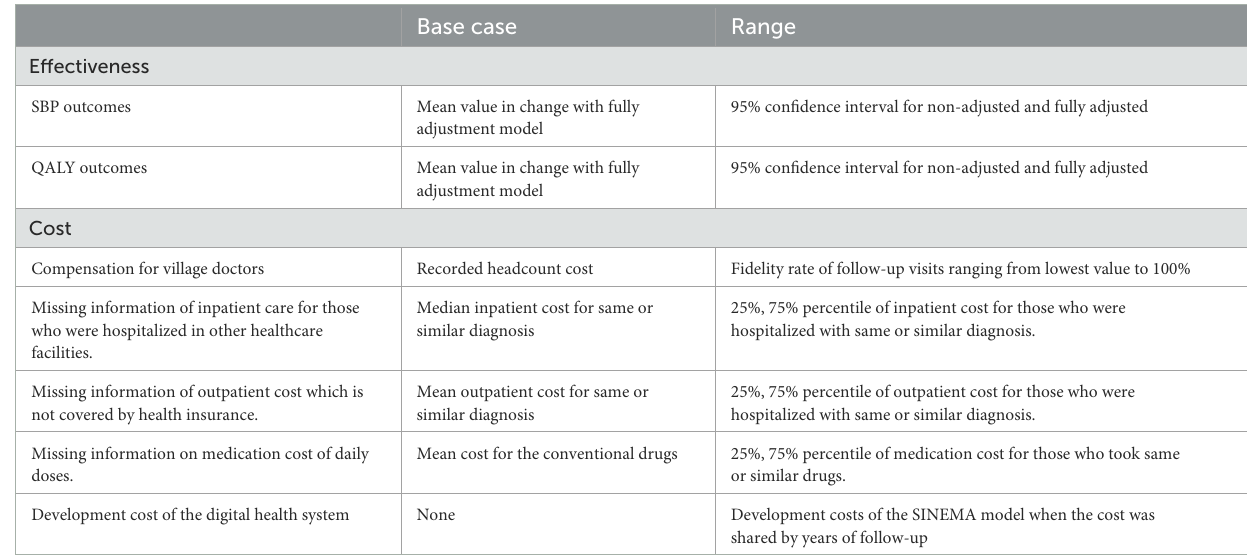
TABLE 2 Sensitive analysis of key